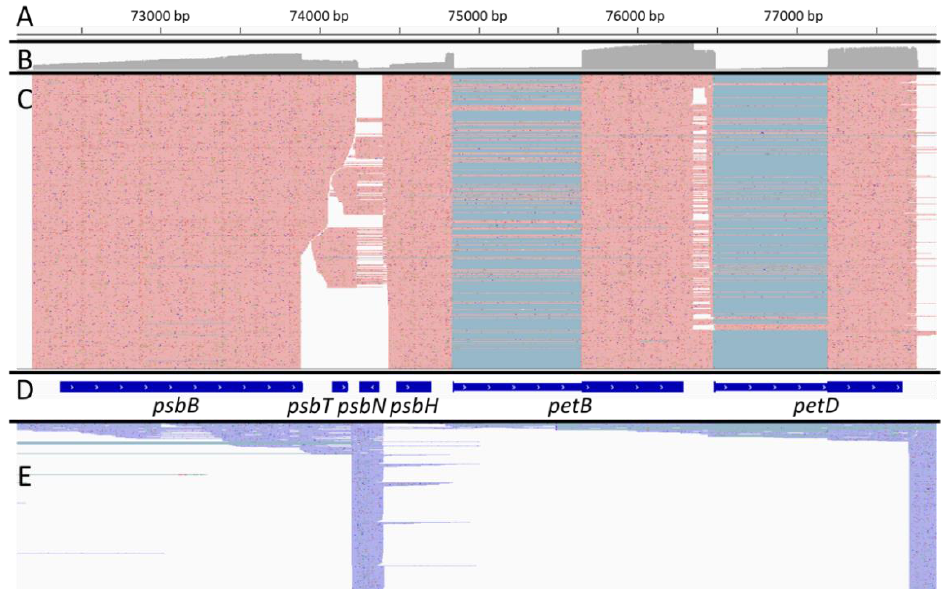
Figure 1. The complexity of the psbB-petD locus. Screenshots of Integrative Genomics Viewer (IGV) displaying nanopore reads mapping to the psbB-petD locus. ( A ) plastid genomic position. ( B ) coverage track displaying the number of reads at each nucleotide. ( C ) screenshot of reads mapping on the Watson strand. Matching bases are shown in red. Split reads are joined by blue lines. ( D ) Annotation of the locus. Introns are shown as thinner segments. ( E ) screenshot of reads mapping on the Crick strand. Matching bases are shown in purple. Split reads are joined by blue lines.